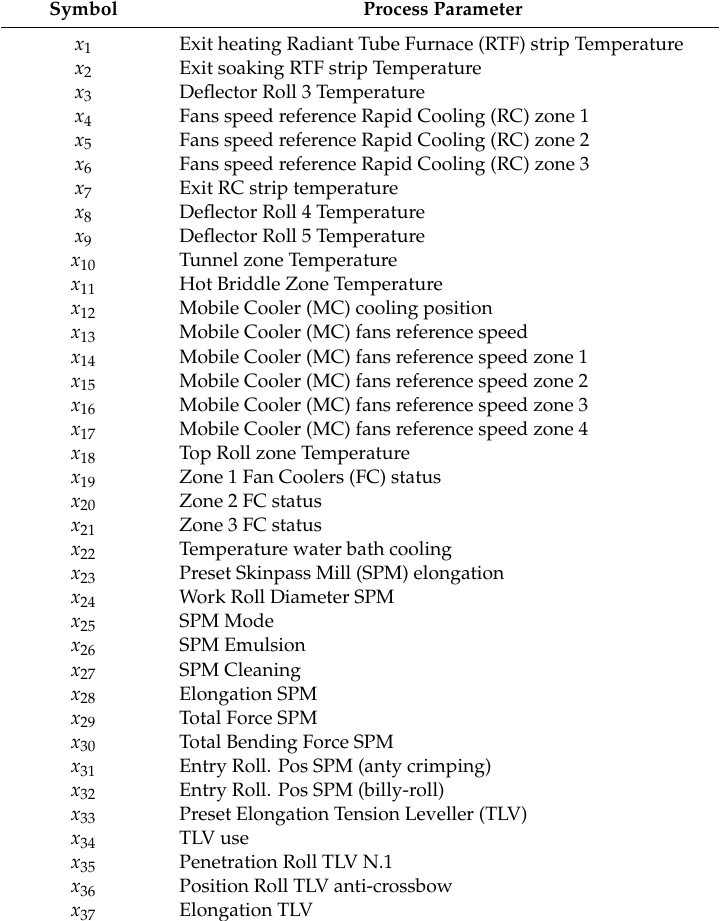
Table 1. List of considered process parameters for HDG